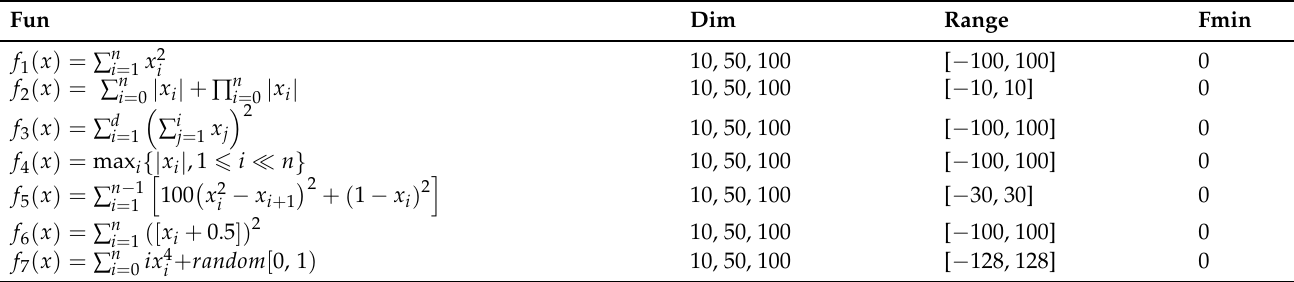
Table 2. Unimodal benchmark functions.